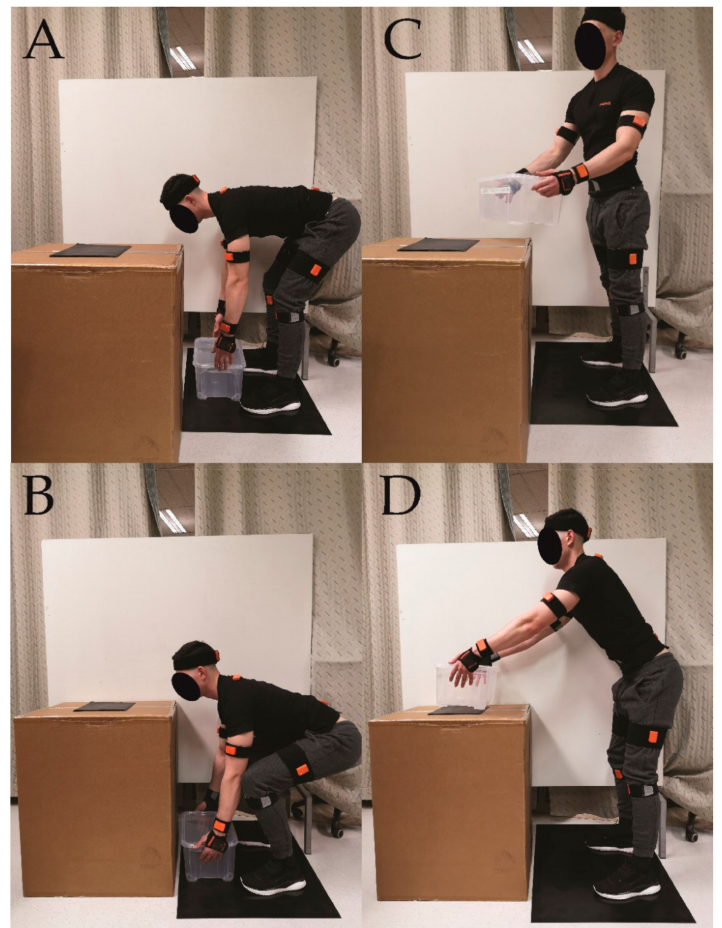
Figure 2. Snapshots of lifting tasks. Note that the sensors installed on the participant are unrelated to this study. The bottom position (start of the lift) differed substantially between stoop ( A ) and squat ( B ) lift. For most lifts, the participants lifted the box only upwards, with the final position in upright posture and box just in front of their hip. However, for the lifts with rotation (ROT), they had to rotate with the trunk towards the left side ( C ), while still maintaining the box close to the body. In the Free-Away lift, they had to position the box over a square placed on the table ( D ). The position from the middle of the square to the middle of the foot was 50 cm for all